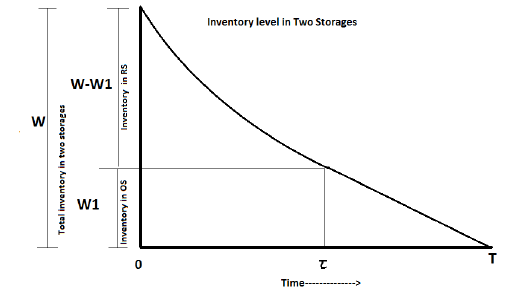
Figure 1. Inventory level at any time t in both the